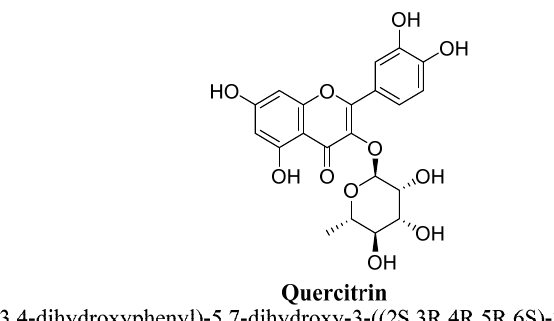
Figure 21. Kaempferol.